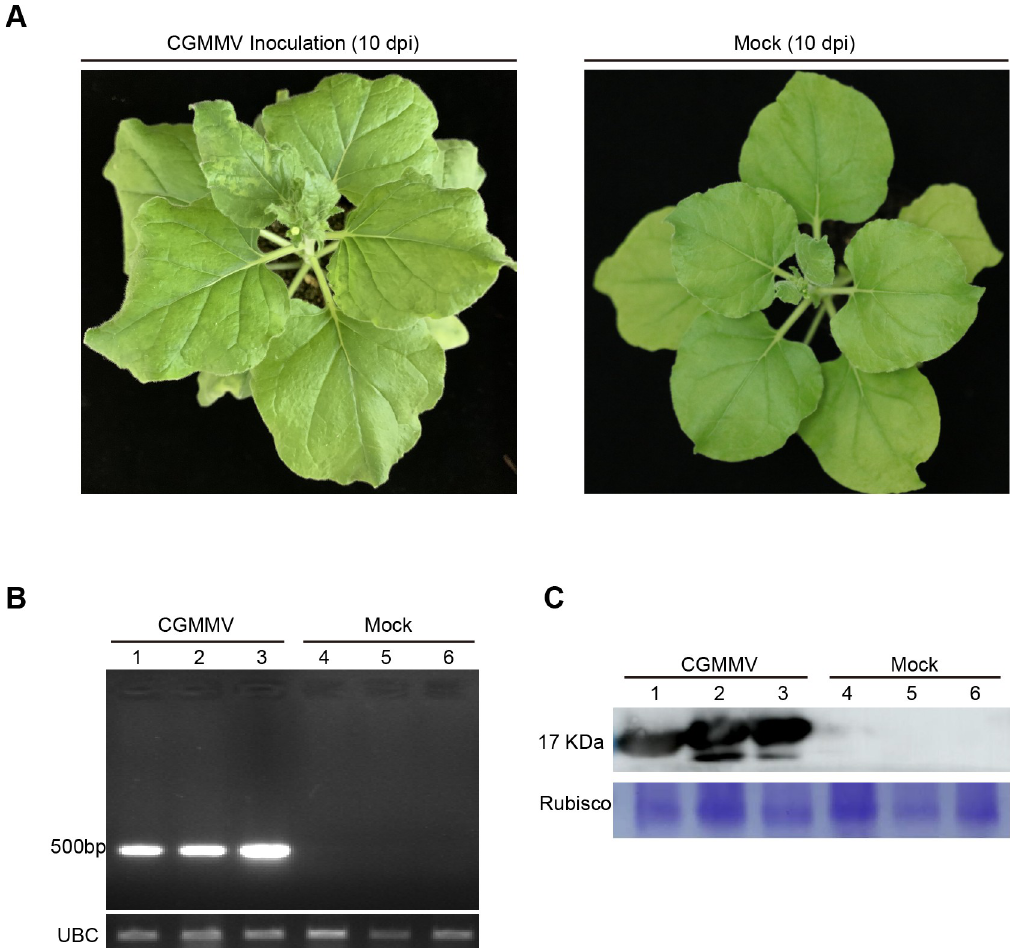
Fig 1. Agroinfiltration of CGMMV to the N . benthamiana plants. (A) Symptoms of CGMMV/mock-inoculated N . benthamiana at 10 dpi. (B) RT-PCR analysis on the CGMMV/mock-inoculated N . benthamiana plants. (C) Western blotting analysis on the CGMMV/mock-inoculated N . benthamiana plants. dpi: days post inoculation.